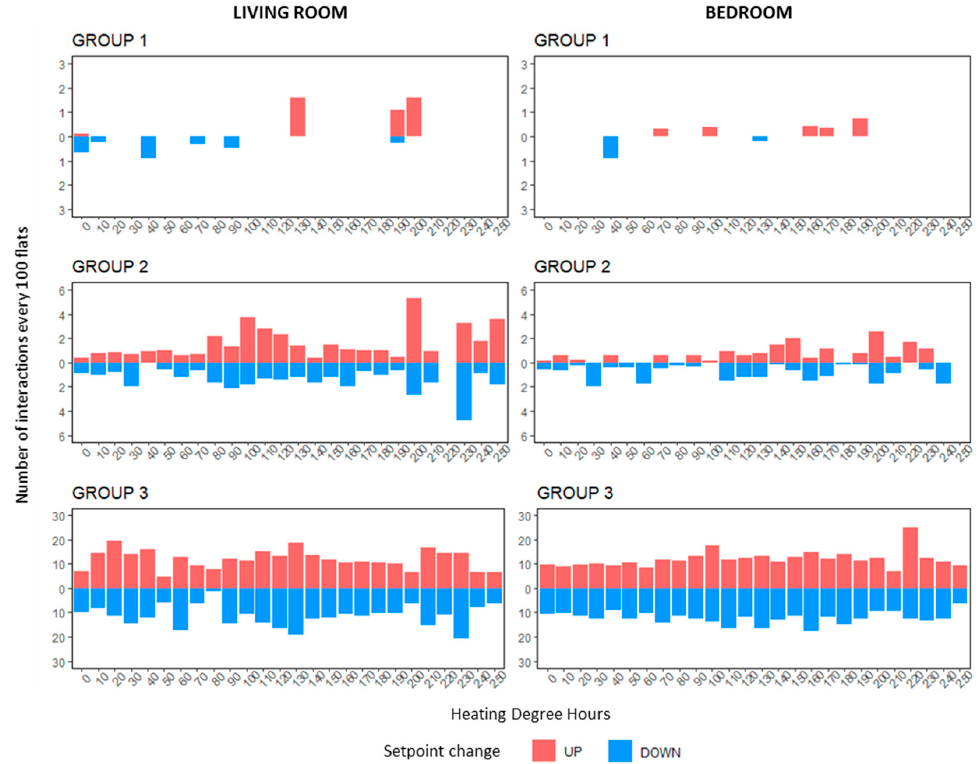
Figure 7. Number of daily interactions with the smart thermostatic valves by heating degree hours/day. Results are scaled to 100 flats to compare across groups and rooms. The number of interactions were weighted by the number of observations of each flat and the frequency of each heating degree hour range for the monitoring period (March 2019 to April 2020).